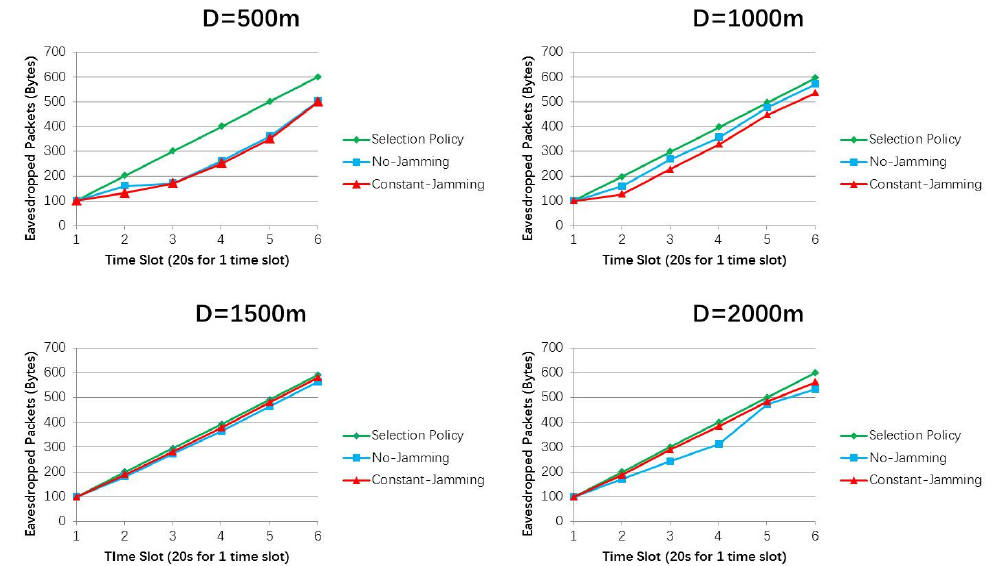
Figure 7. Eavesdropped packets by UAV L in different Ds with different jamming methods.